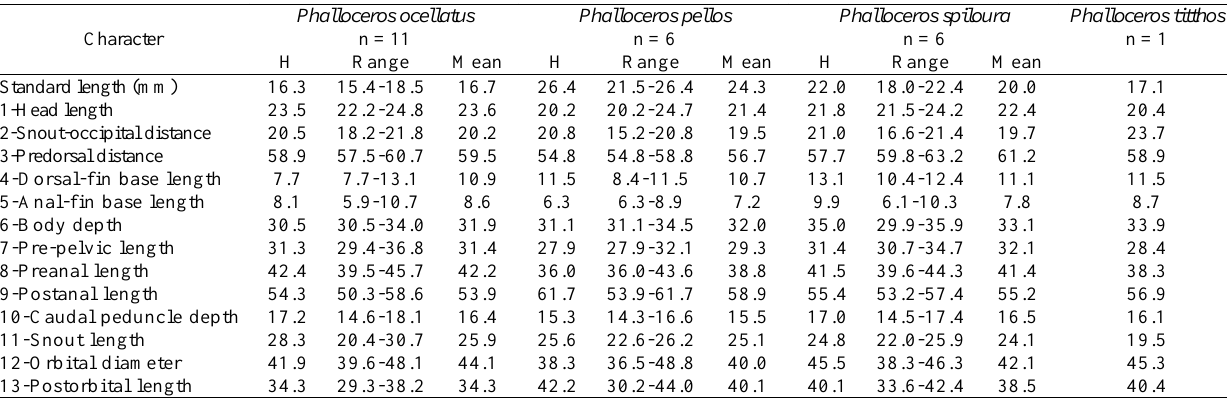
Table 12 . Descriptive morphometrics of male specimens of Phalloceros ocellatus , P . pellos , P . spiloura , and P . titthos .